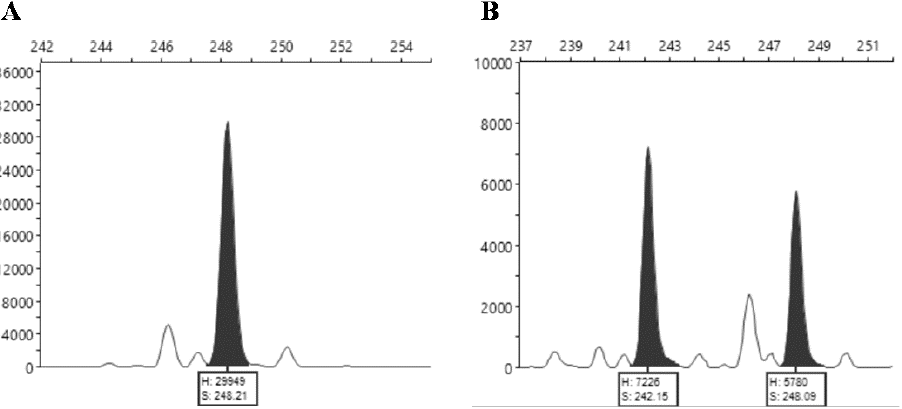
Figure 3. Capillary polyacrylamide gel electropherograms of the locus MT317577 ( A ) Homozygous pattern of accession 15; ( B ) Heterozygous pattern of accession 37. X axis — Fragment size (bp); Y axis —Relative Fluorescence Unit (RFU). Notice the associated smaller “stutter” peaks.